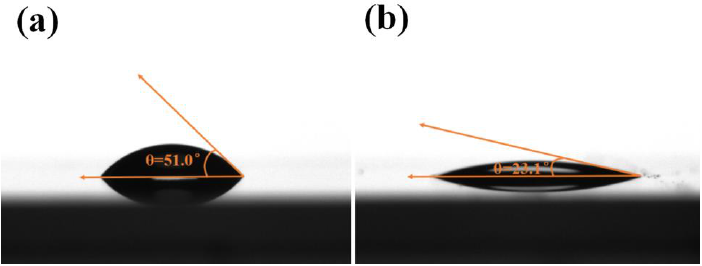
Figure 12. Illustration of contact angles formed by liquid drops on smooth glass slides: ( a ) Ethanol: water = 0:100 ( v / v ), 2 g/LFeSO 4 ·7H 2 O; ( b ) Ethanol: water = 60:40 ( v / v ), 2 g/L FeSO 4 ·7H 2 O.